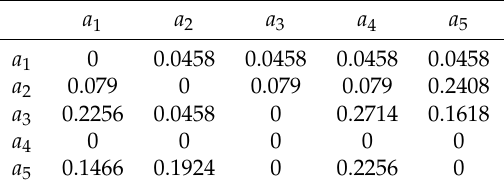
Table 11. Comprehensive dominance degrees between hotels in Method 1.